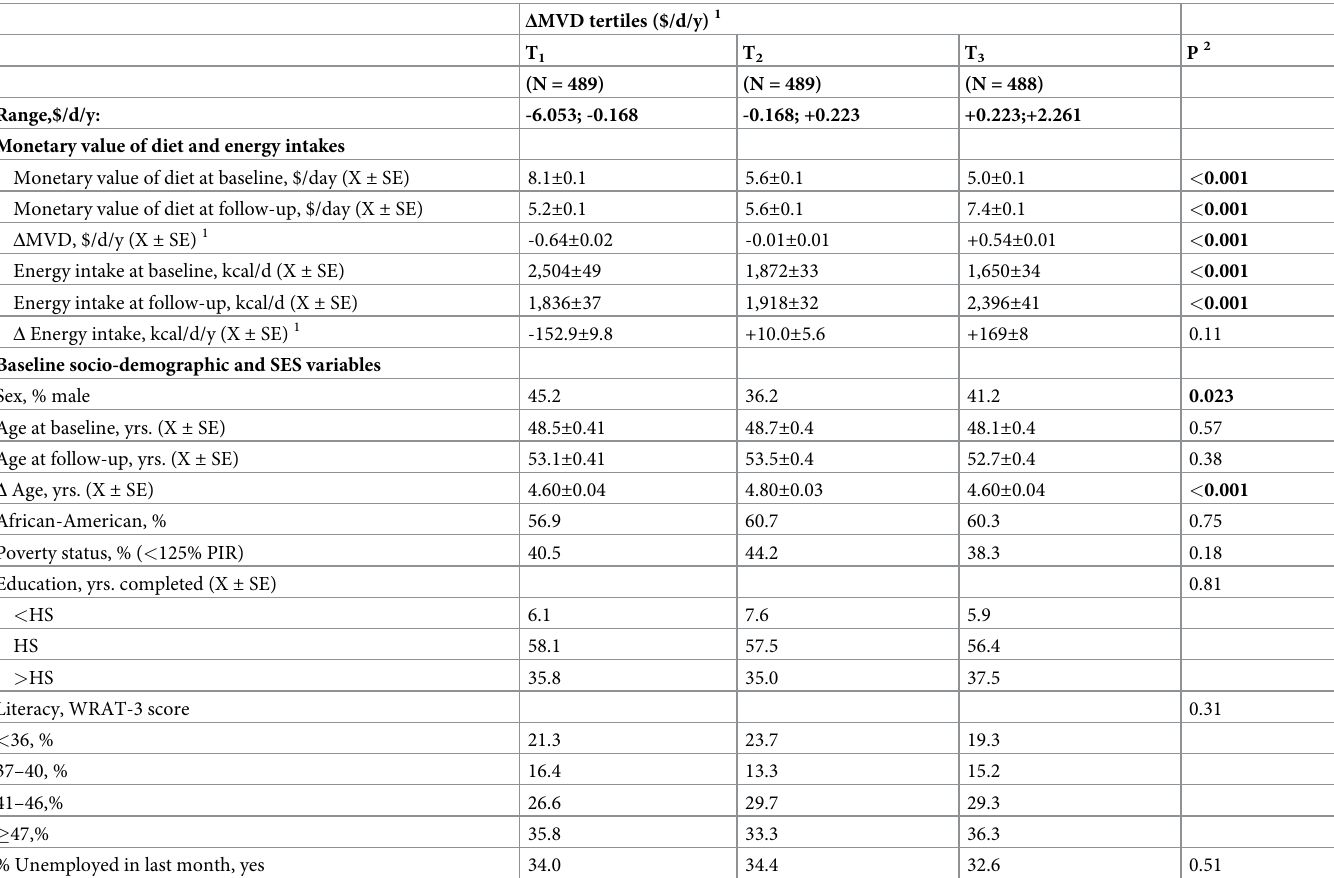
Table 1. Study sample characteristics by tertile of longitudinal change in the monetary value of diet ( Δ MVD, $/d), HANDLS 2004–2013 3 . Δ MVD tertiles ($/d/y)